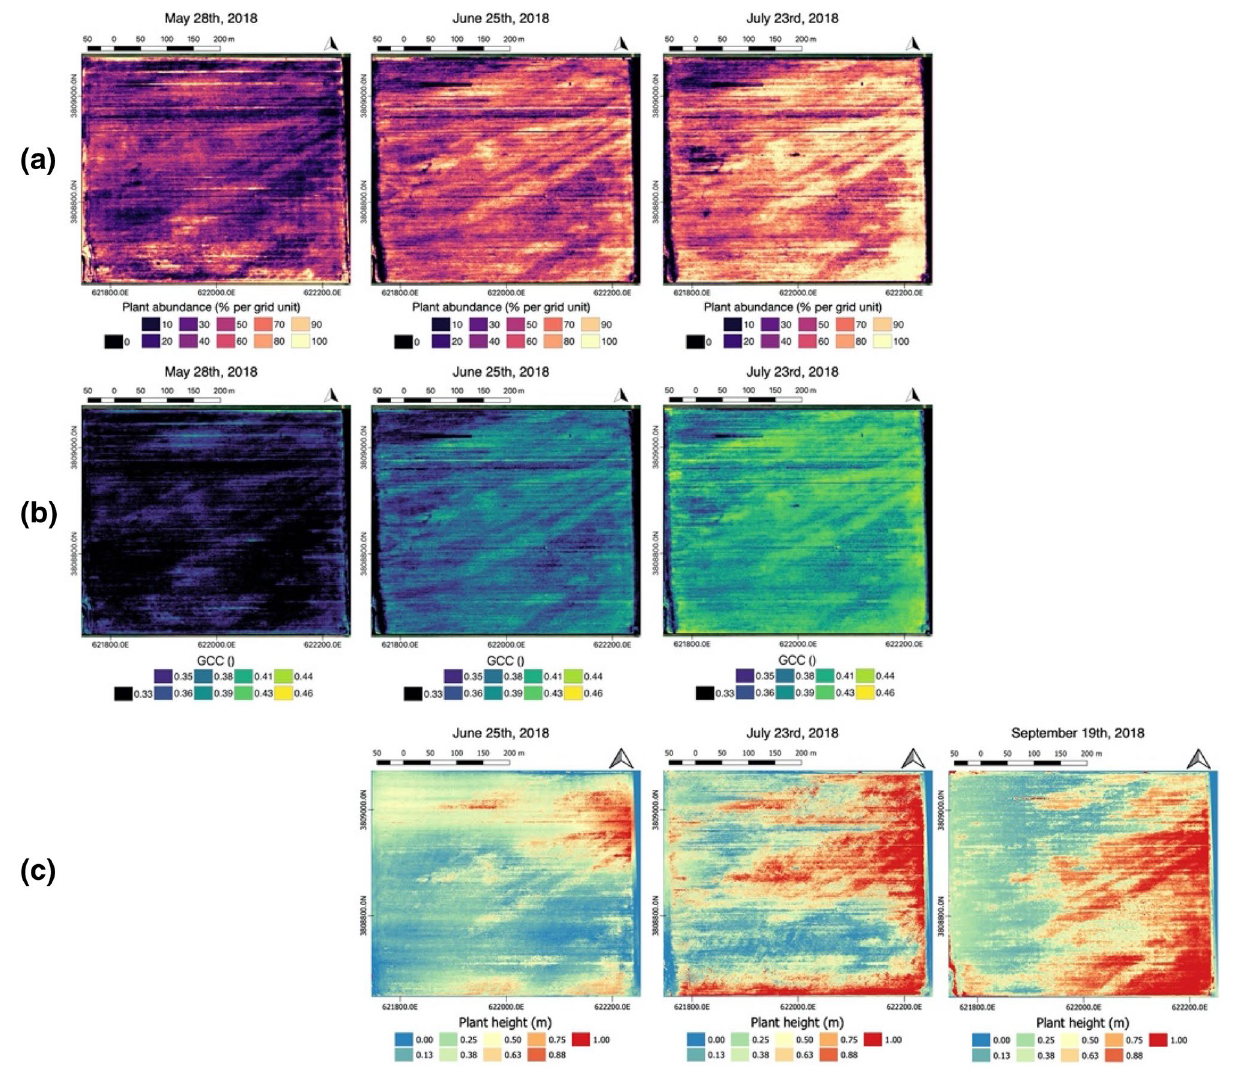
Figure 4. UAV products consisting of: ( a ) plant spatial abundance; ( b ) plant-specific vigor represented by the GCC index; and ( c ) plant height. The maps are vertically aligned accrding to their temporal acquisiton. Maps made with QGIS (v 3.6, https:// www. qgis. org) 36 .